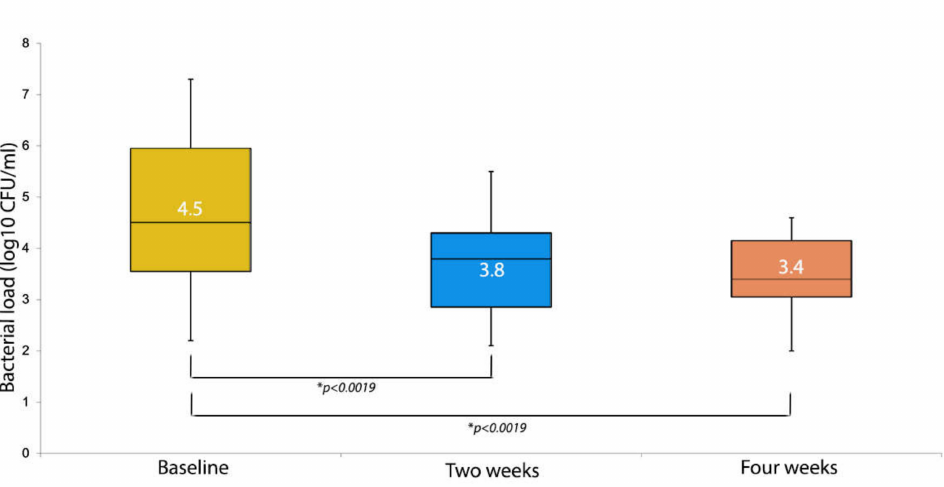
Figure 2. Bacterial load at each visit (log10 CFU/mL). For each box plot, the median values are represented by the line within the box. The box represents 50% of the values (the 25th and 75th centiles), with the bars indicating the highest and lowest values excluding the outliers. * is p